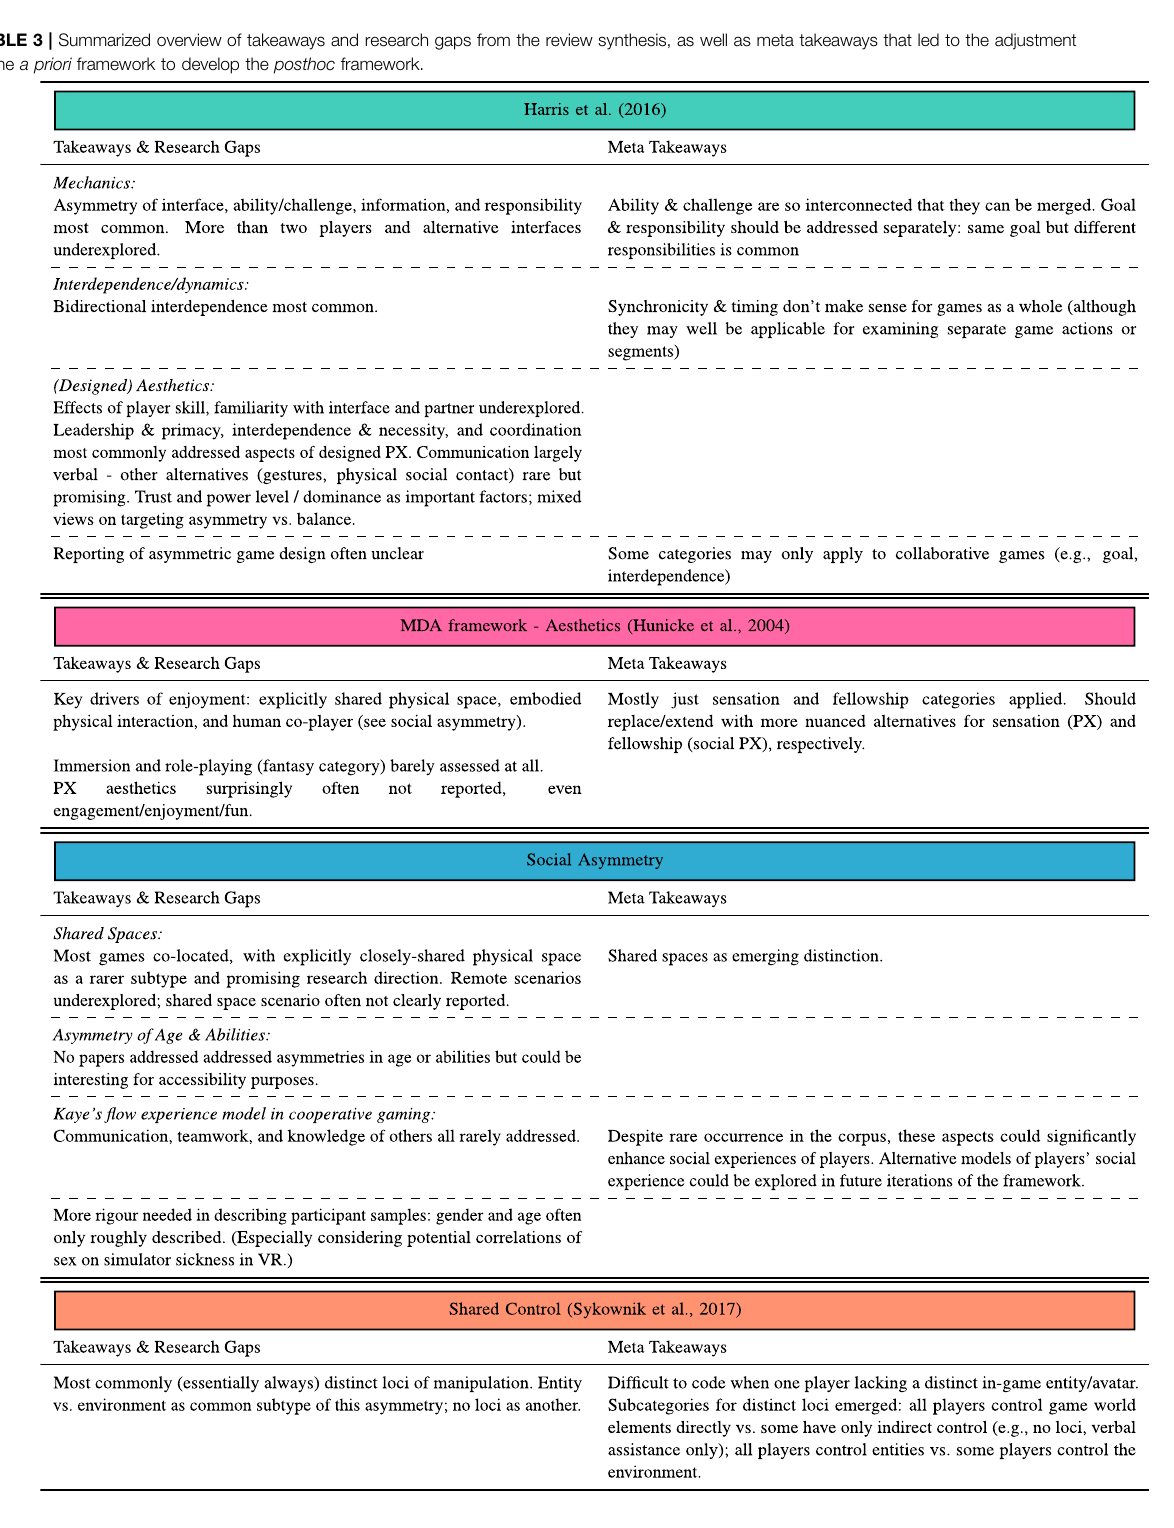
Frontiers in Virtual Reality |